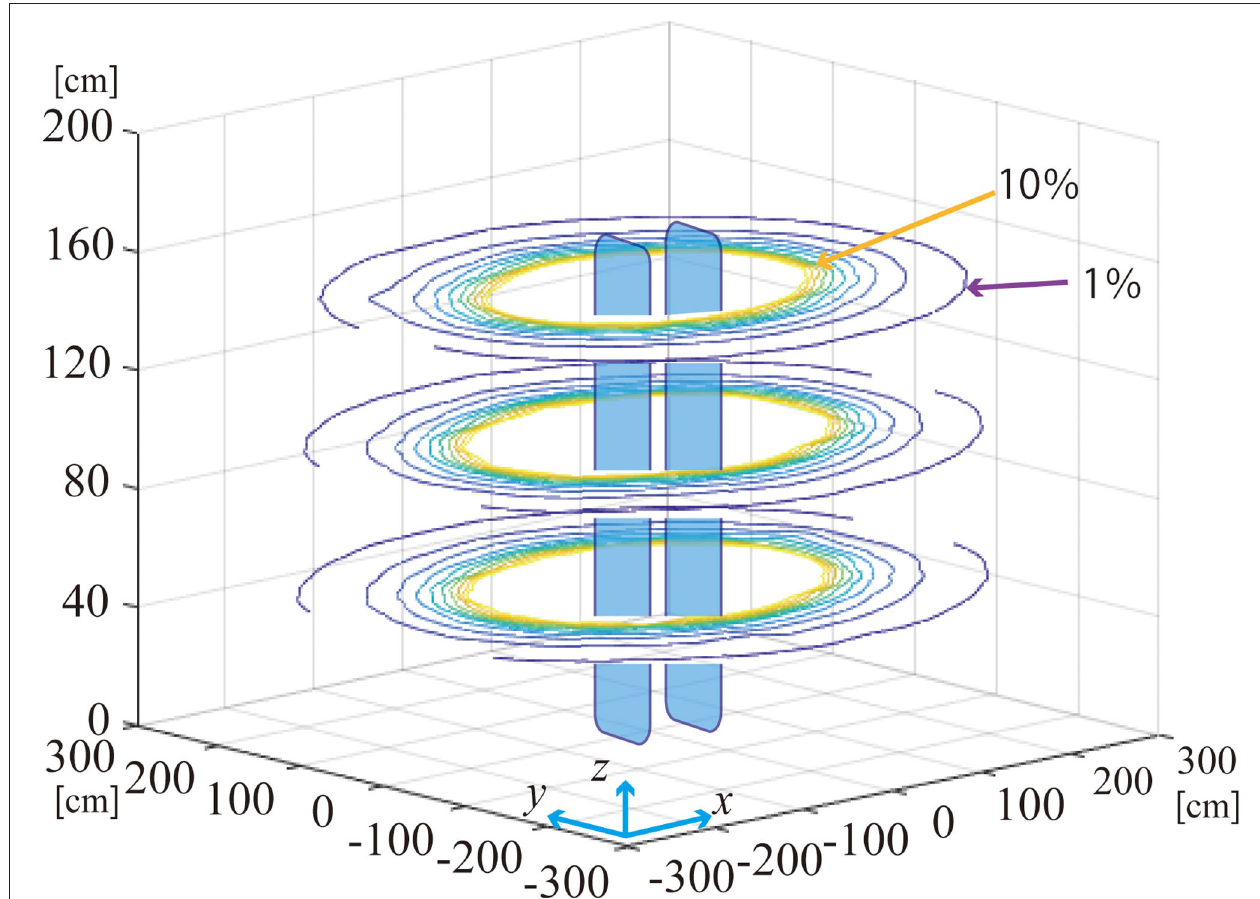
FIGURE 5 | Contour map of magnetic flux density (resultant rms value) surrounding EAS gate G2 in zone D.